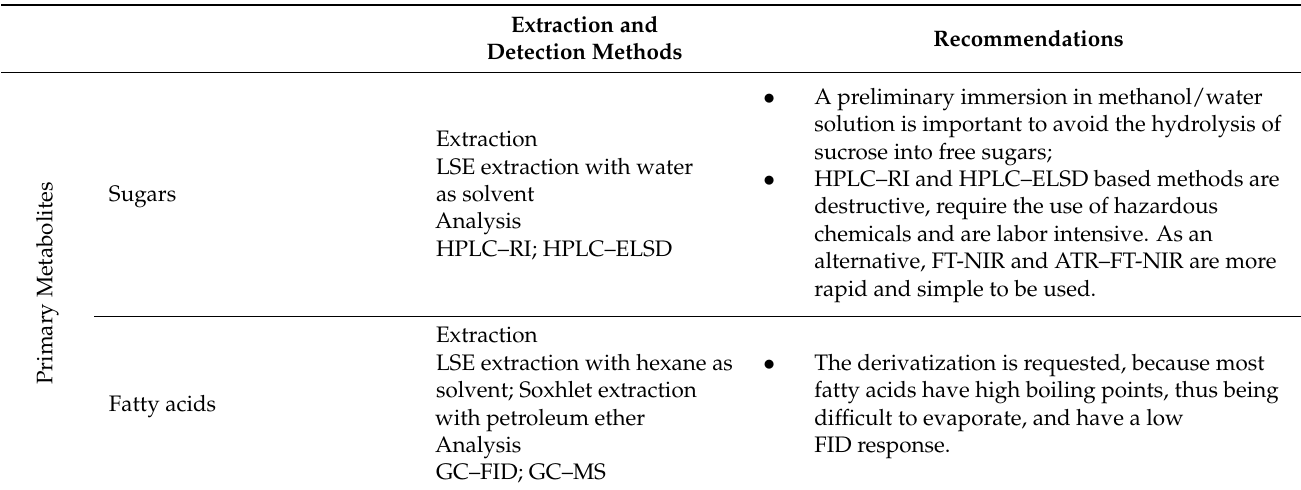
Table 2. Main extraction and detection methods used for apples primary and secondary metabolites, with their recommendations. Extraction